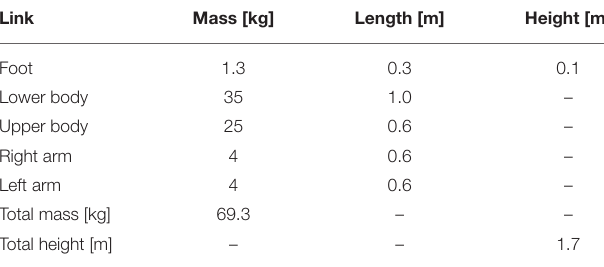
TABLE 1 | Physical parameters of the three-joint, five-link